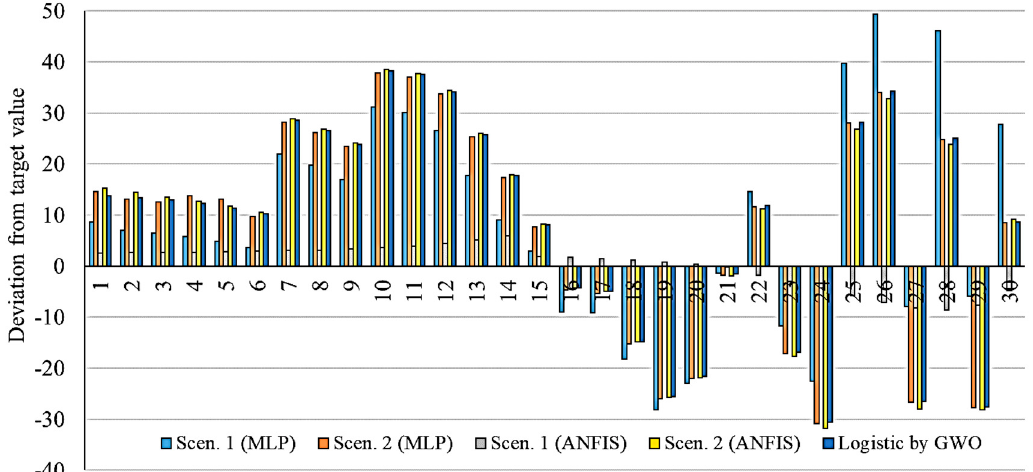
Figure 18. Deviation from target value for models related to China.